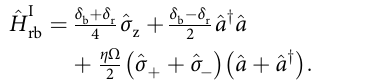
(cid:5) (cid:5) (cid:6) (cid:6) (cid:5) (cid:5) ¼ F ¼ 1 ; m ¼ 0 and F q ffiffiffiffiffiffiffiffiffiffiffiffiffiffiffi ffiffiffiffiffiffiffiffiffiffi p ω ¼ 2 η Ω = δ 2 ω (cid:2) δ 2 g (cid:5) 2 λ = . Since the uncoupled Hamilto- a f b r